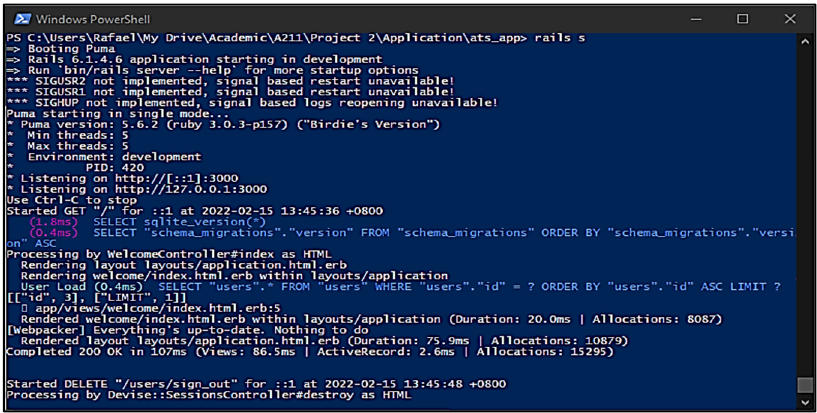
Figure 8. Server running on Windows via Microsoft PowerShell.